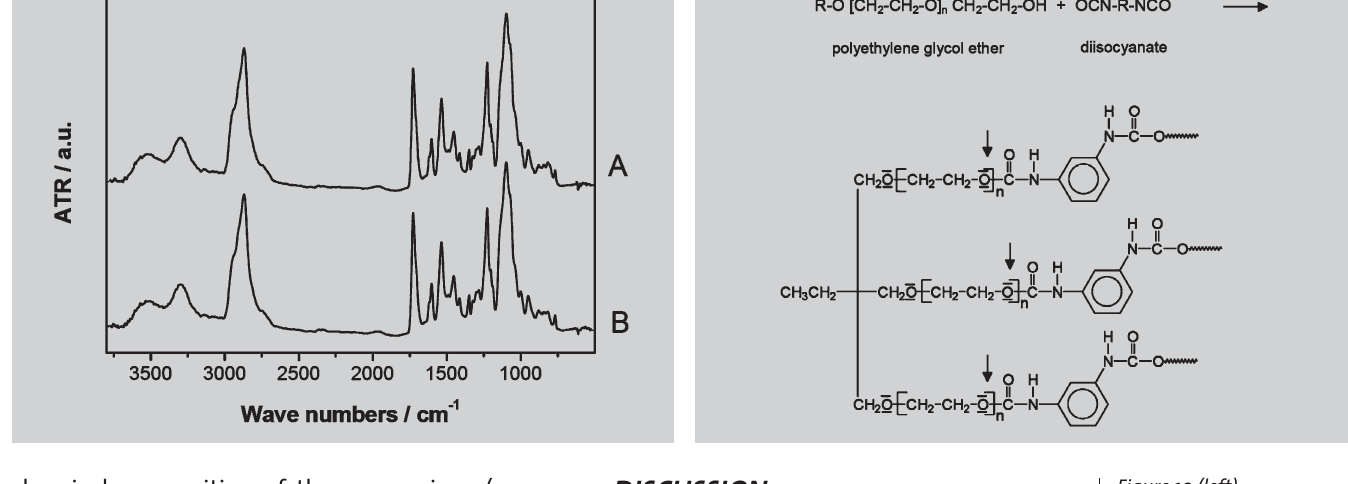
Figure 10 (left): Infrared spectra (ATR) of the filter residues of the electro- rheological fluids suspen- sion A and B [12]. Figure 11: A representation of the sim- plified structural formula of a trimethylolpropane-based polyether urethane cross- linked with phenyl di-iso- cyanate. The oxygen atoms available for the dative bond to Li + or Zn 2+ ions are marked with arrows. Table 1: Results of the analytical characterization of the ER